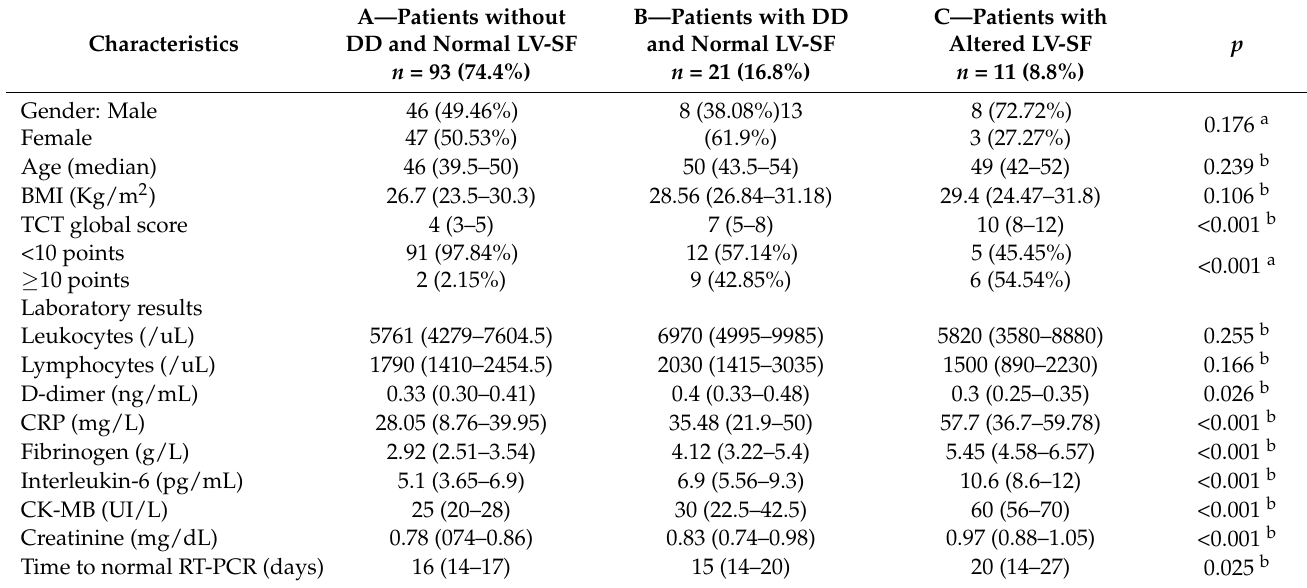
Table 2. Demographic and laboratory characteristics of study